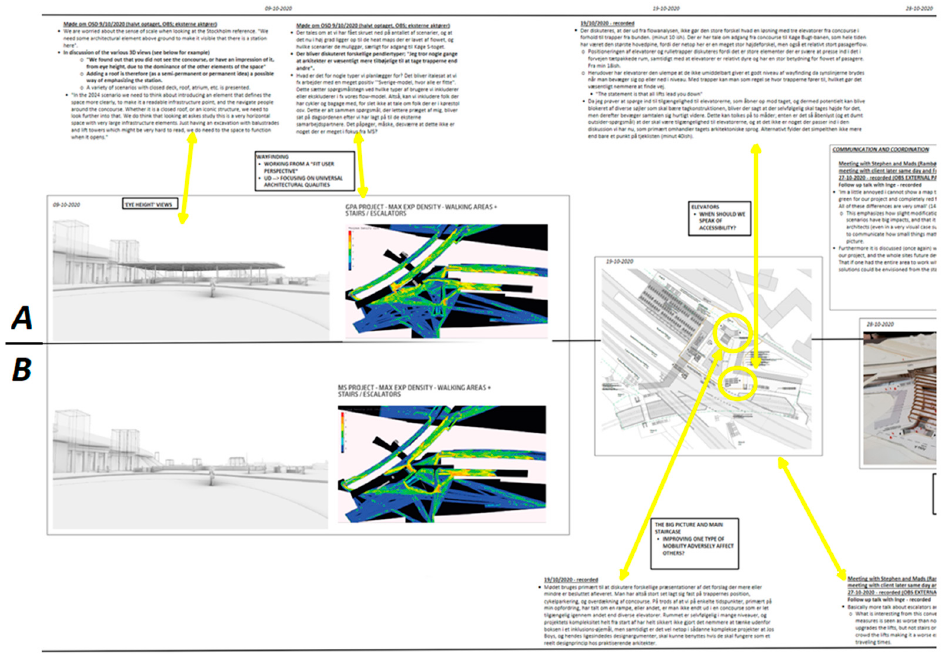
Figure 2. Step 3 of the analysis, as visualized through a timeline. A indicates field notes associated with generalized presence. B indicates field notes associated with required presence.